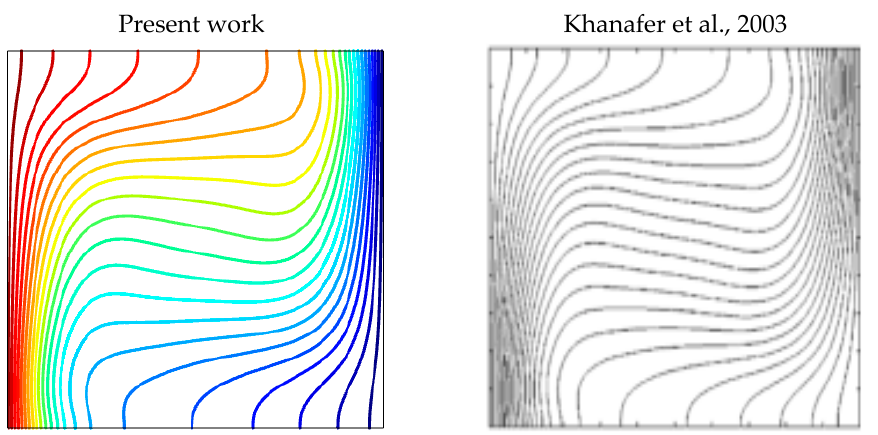
Figure 3. Comparison between present and published results of Khanafer et al. [4] by fixing Pr = 6.2, Ra = 6.2 × 10 4 , and φ =